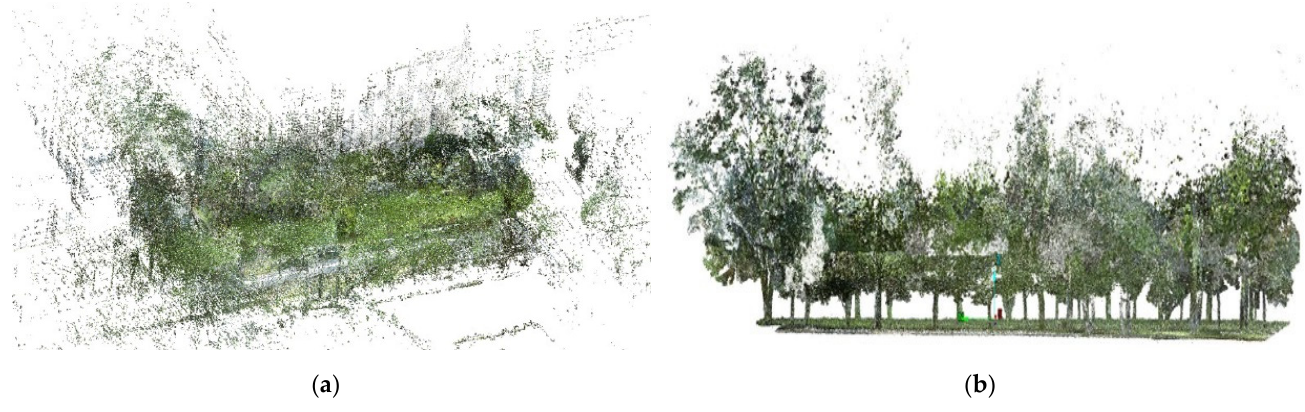
Figure 13. Point cloud denoising and cropping diagram. (( a ) shows before denoising and cropping; ( b ) shows after denoising and